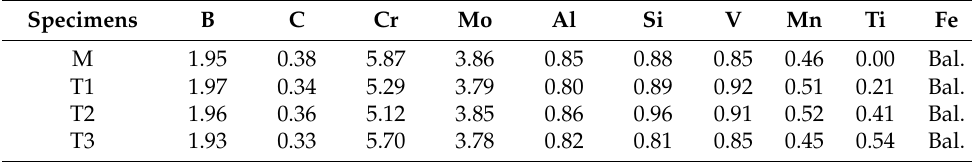
Table 2. Chemical compositions of alloys (wt.%).